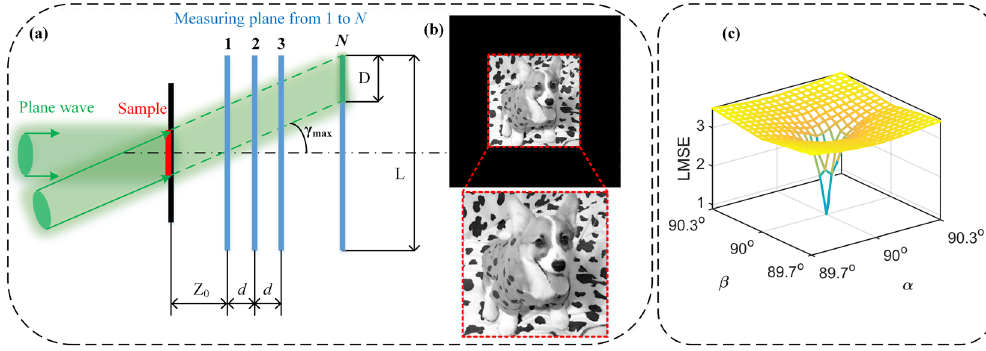
Figure 2. The image reconstruction test using APR: ( a ) The diffraction boundary of tilt illumination. ( b ) The ground truth for test. ( c ) The LMSE distribution between ground truth and reconstructed amplitude by APR algorithm under tilt